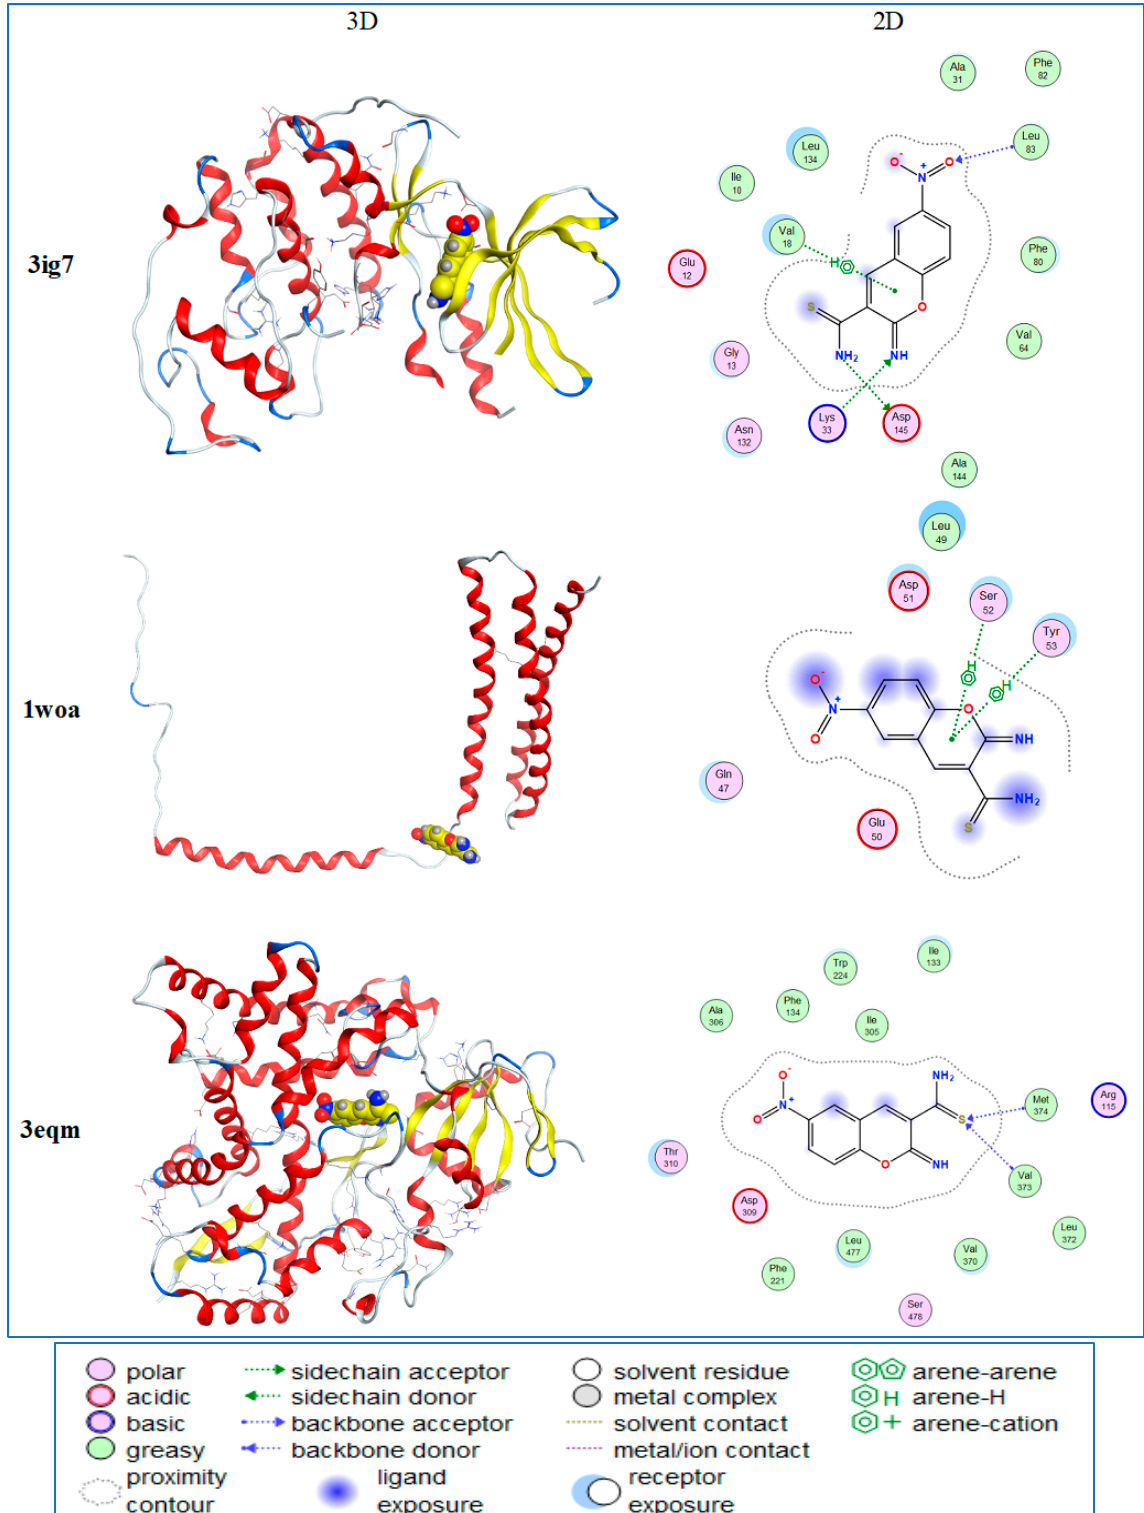
Figure 4. Molecular docking of 2 H -1-benzopyran-3-carbothiamide with the receptors cyclin-dependent kinase 5 (3ig7), erythroid spectrin (1woa), aromatase cytochrome P450 (3eqm), and topoisomerase (4fm9).